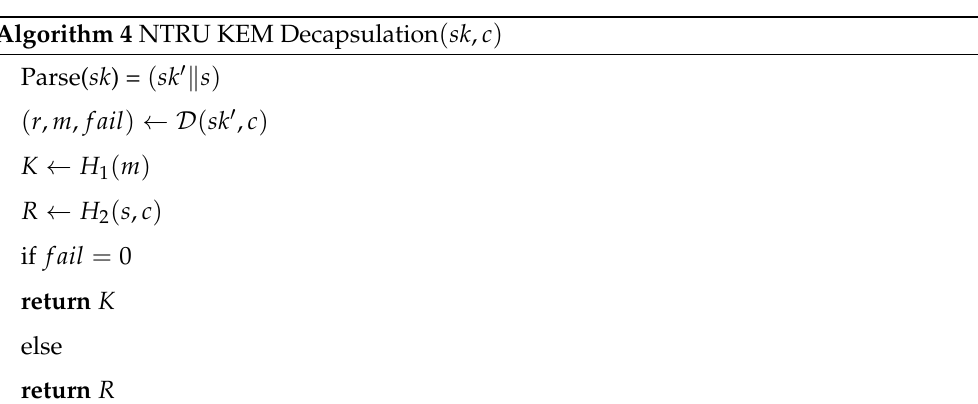
Algorithm 4 NTRU KEM Decapsulation ( sk , c